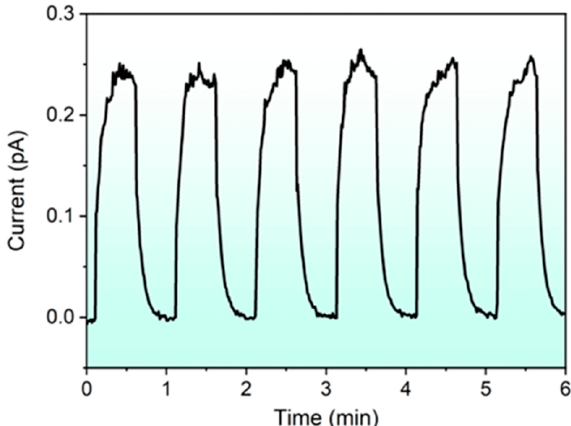
Figure 10. Photoresponse characteristic and stability of the device.